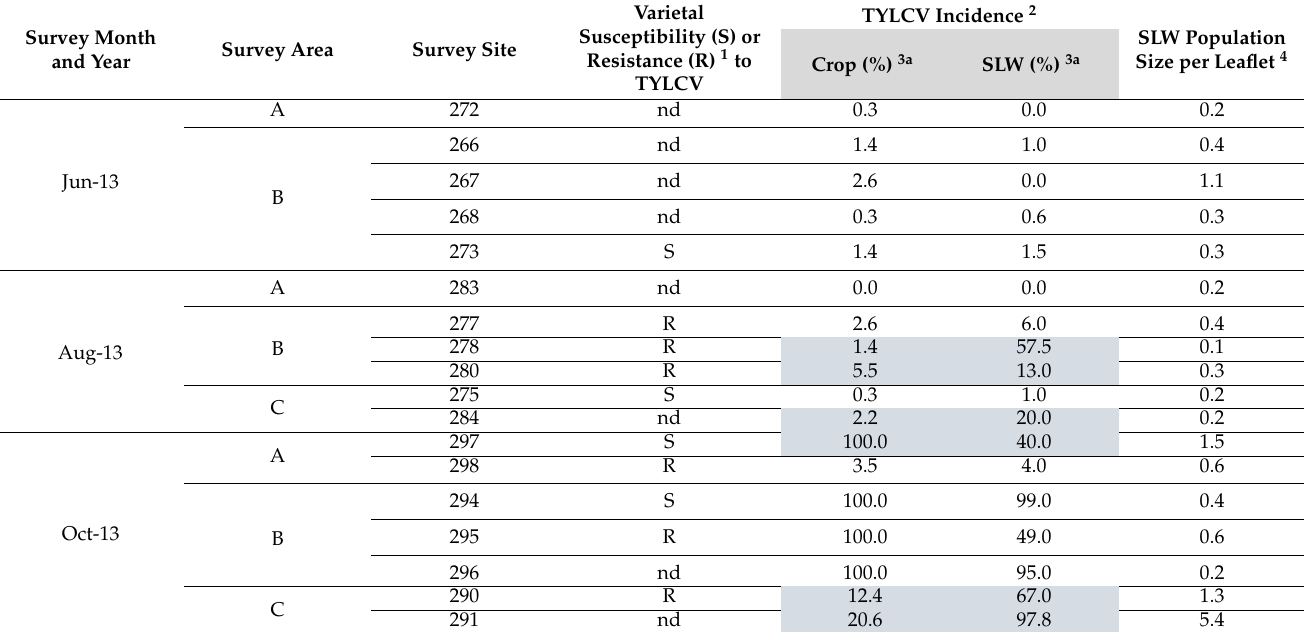
Table 1. List of sites surveyed for silverleaf whitefly (SLW) and tomato yellow leaf curl virus (TYLCV) since June 2013. The incidence of TYLCV in crop and adult SLW was assessed through molecular indexing is provided for each site, in addition to the number of SLW collected and the estimated population size of SLW per leaflet. Sites were identified to have migratory SLW populations if there was a poor correlation between TYLCV detections in SLW and the crop. These are indicated by grey shading where the TYCV-SLW is >one-third of the TYLCV -crop incidence and orange shading where the reverse occurs. For sites where the TYLCV incidence is <5% or the proportion of TYLCV-SLW are considered to correlate well with TYLCV-crop incidences (i.e., values < one-third different), there is no shading, and data was not evaluated for correlations. Instances where data was not determined are indicated by